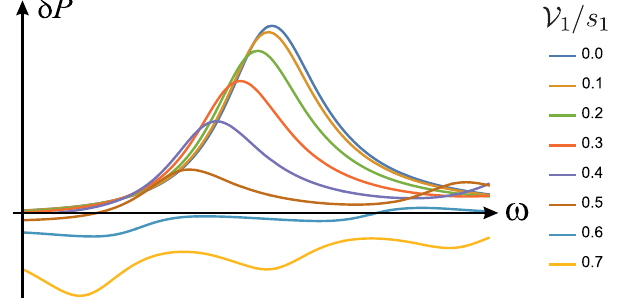
FIG. 14. Dissipation in the channel for different values of V 1 =s 1 .